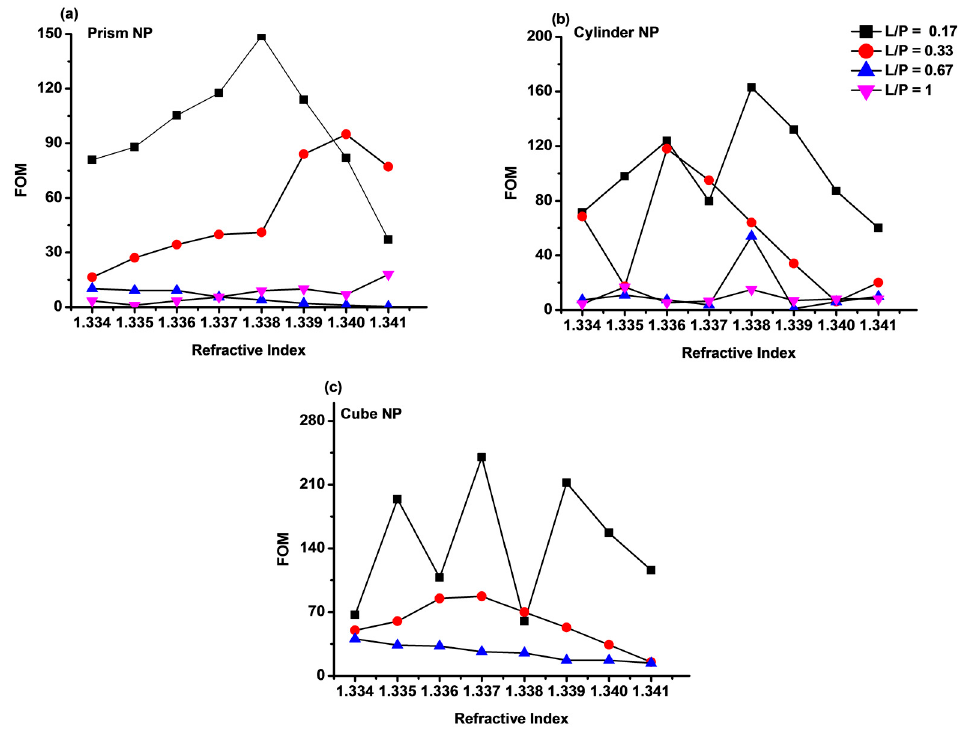
Figure 8. FOM of the hybrid Au-G nanostructure with ( a ) prism; ( b ) cylindrical; and ( c ) cubic NPs at different L/P ratios as a function of the refractive index.